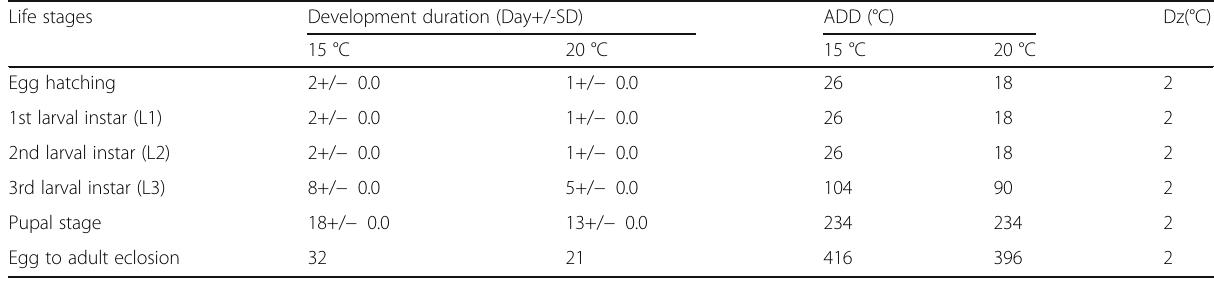
Table 2 Development duration and thermal requirements (ADD) of Calliphora vicina (second generation) at constant temperatures (RH = 70%, Photoperiod= 10: